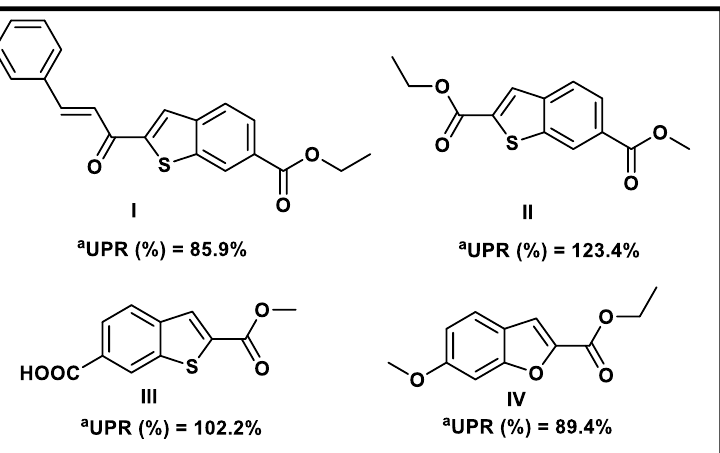
Figure 1. Reported benzothiophene and benzofuran derivatives as BMP-2 up-regulators. a UPR: Up-regulatory percent Activities on BMP-2 expression.